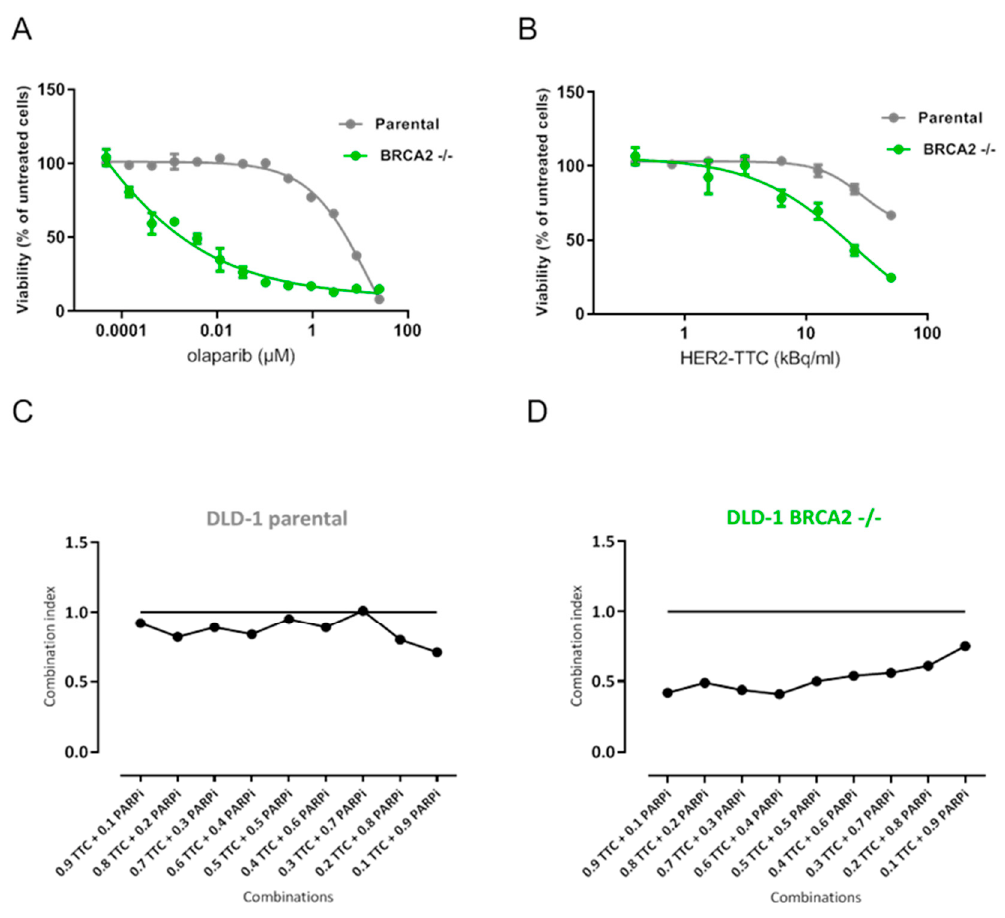
Figure 2. In vitro characterization of HER2-TTC and olaparib in DLD-1 parental and DLD-1 BRCA2- / - cell lines. ( A ) Single treatment poly ADP ribose polymerase inhibitor (PARPi), olaparib, on DLD-1 parental and DLD-1 BRCA2- / - and ( B ) single treatment HER2-TTC on DLD-1 parental and DLD-1 BRCA2 - / -. combination index plot for evaluation of combination with HER2-TTC and olaparib on ( C ) DLD-1 parental and ( D ) DLD-1 BRCA2- / -. The CI was determined according to the median-e ff ect model of Chou-Talalay, with CI < 0.8 defined as synergistic e ff ect, 0.8 < CI > 1.2 defined as additive e ff ect, and CI > 1.2 defined as antagonistic e ff ect [24].